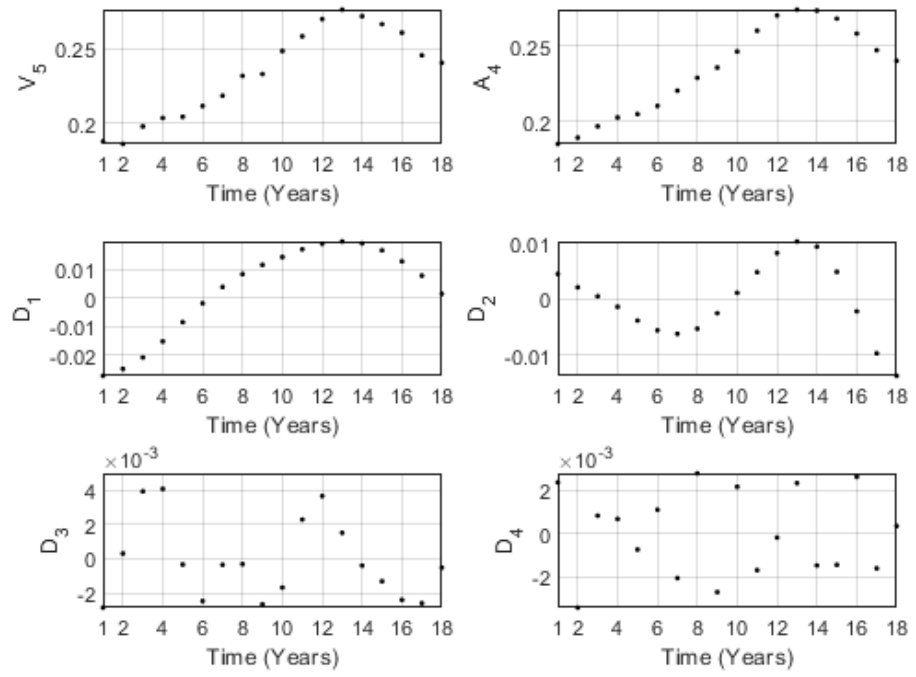
Figure 5. The wavelet decomposition of the variable V 5 at the level